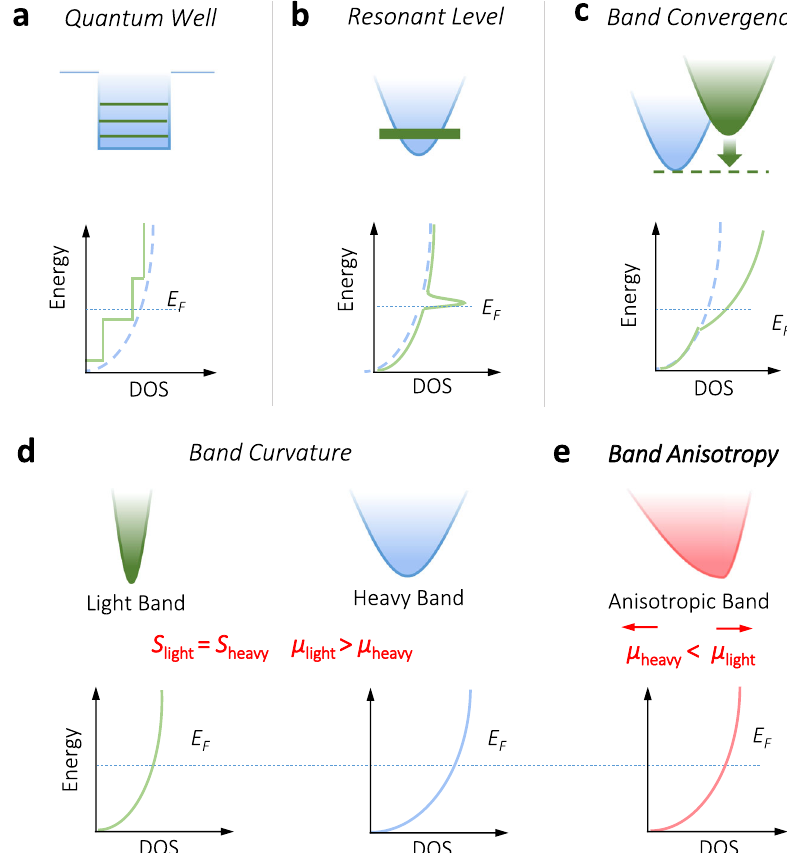
Fig. 1 Schematic representations of the band structures and DOS for different band engineering strategies. a Quantum well. b Resonant level. c Band convergence. d Band curvature and e band anisotropy. In d and e , the position E F is assumed to be the same for the light band, heavy band, and anisotropic band, indicating the same S . The difference in the μ of light- and heavy-bands and along different directions of the anisotropic band is